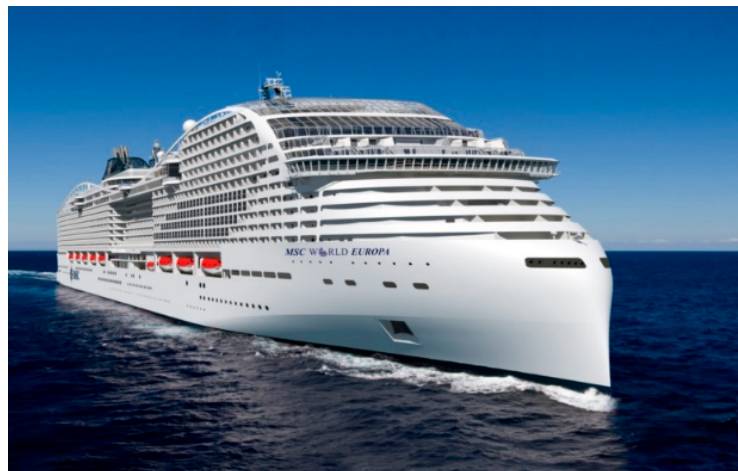
Figure 4. The cruise ship “MSC World Europa” [31].